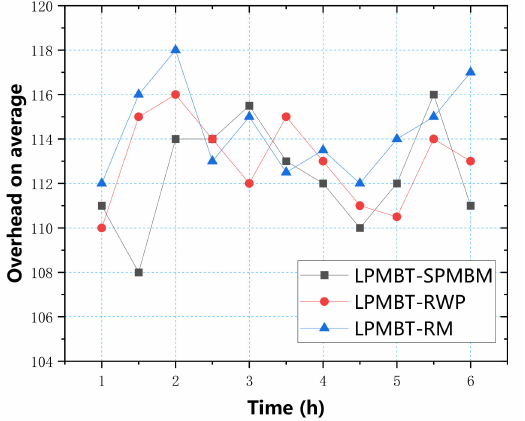
Figure 13. Overhead on average in three mobile